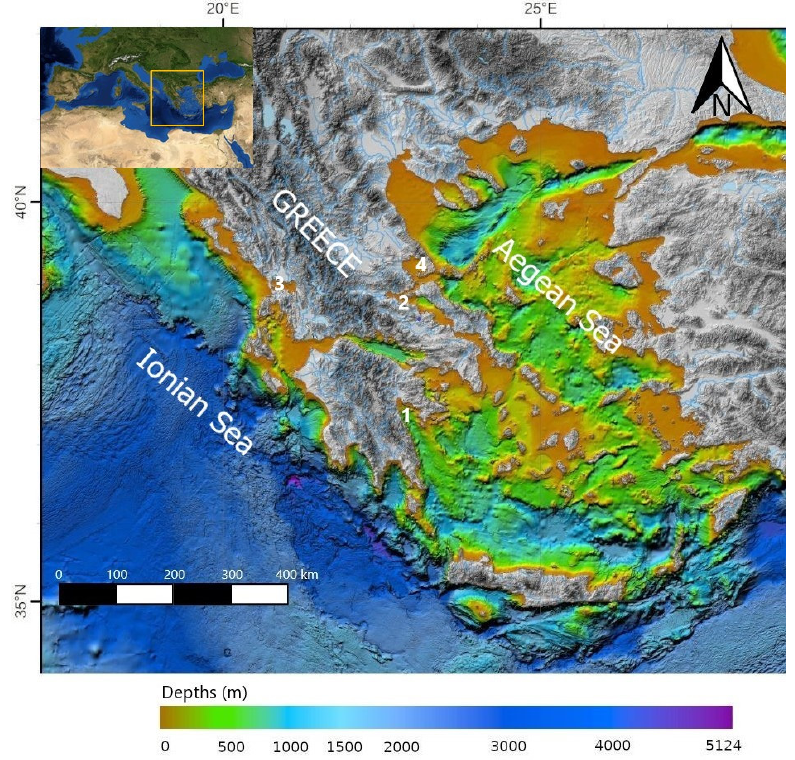
Figure 1. The study area of batoid diversity overview in the eastern Mediterranean Sea, indicating the two main districts: eastern Ionian Sea and Aegean Sea (Gulfs: 1 = Argolikos, 2 = Maliakos, the two main districts: eastern Ionian Sea and Aegean Sea (Gulfs: 1= Argolikos, 2= Maliakos, 3= 3 = Amvrakikos, 4 = Amvrakikos, 4= Pagasitikos).